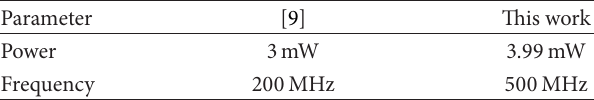
Table 10: Comparison of power and frequency.